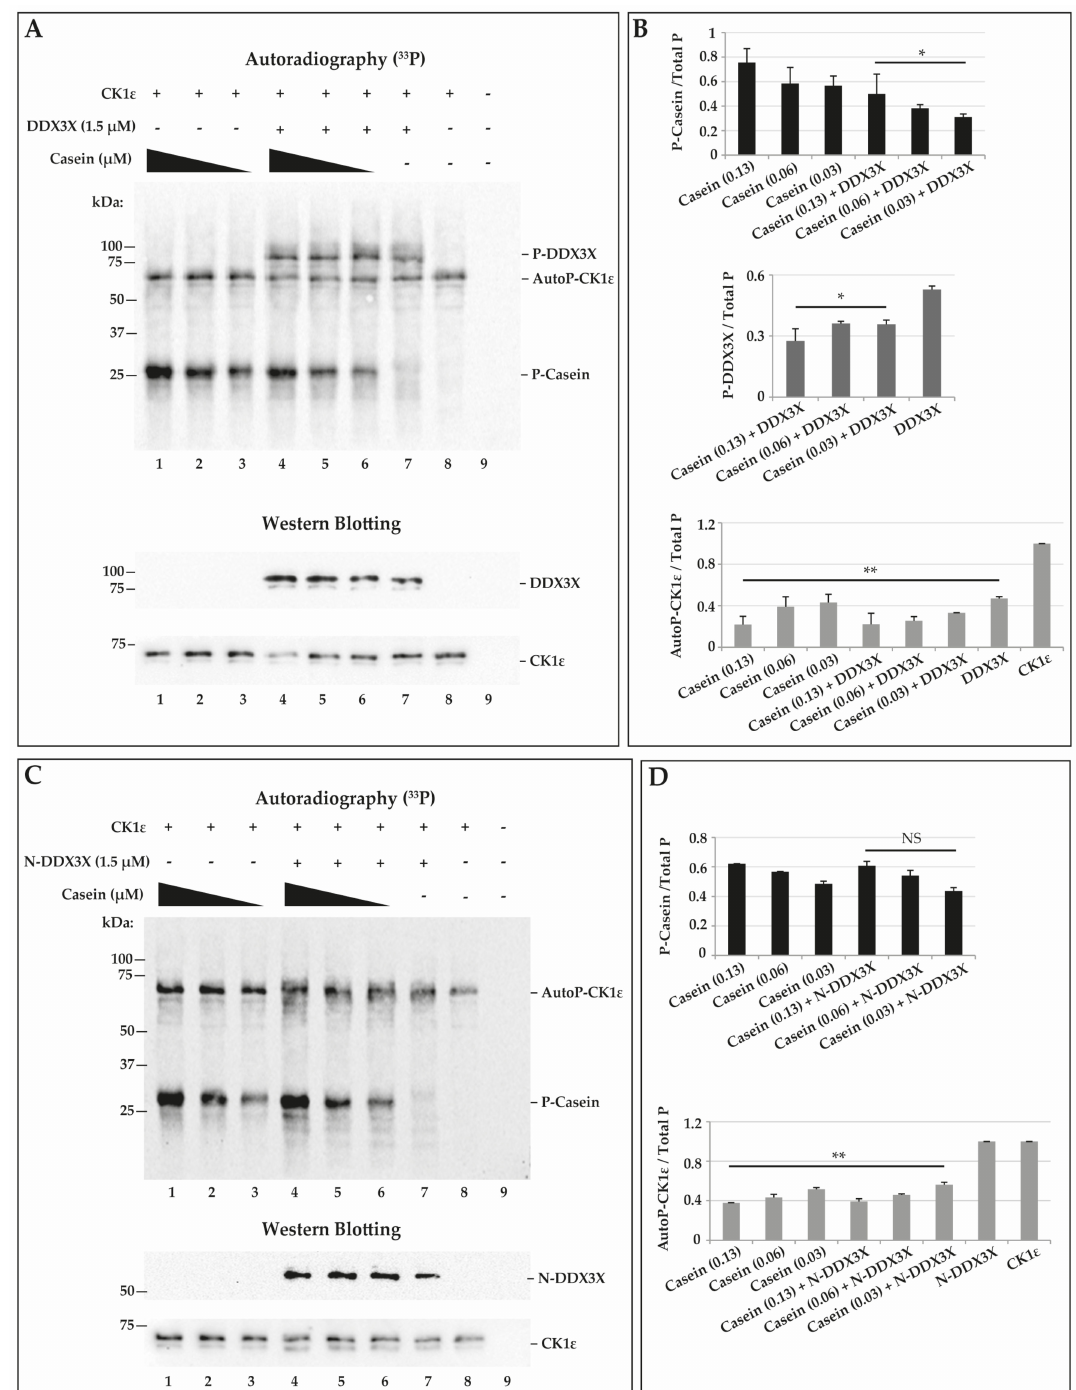
Figure 6. E ff ect of the presence of DDX3X on casein phosphorylation by CK1 ε . ( A ) DDX3X, CK1 ε , and casein γ - 33 P incorporation visualized by autoradiography on nitrocellulose membrane (upper panel). Westernblotanalysisofthesamemembrane(lowerpanels). ( B )Quantificationofautoradiographic γ - 33 P signal (panel A). Bars indicate mean ± SD. ( C ) Representation of CK1 ε and casein γ - 33 P incorporation on nitrocellulose membrane visualized by autoradiography (upper panel). Western blot analysis of the same membrane (lower panel). ( D ) Quantification of autoradiographic γ - 33 P signal (panel C). Bars indicate mean ± SD. * and ** indicate p -value < 0.05 and < 0.01 respectively. NS: not